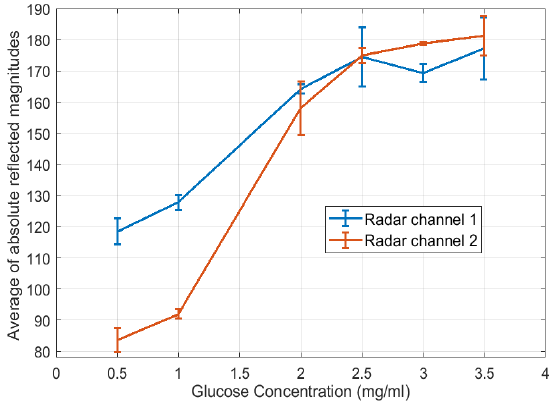
Figure 8. Averages of absolute magnitudes in the three trials and corresponding error.